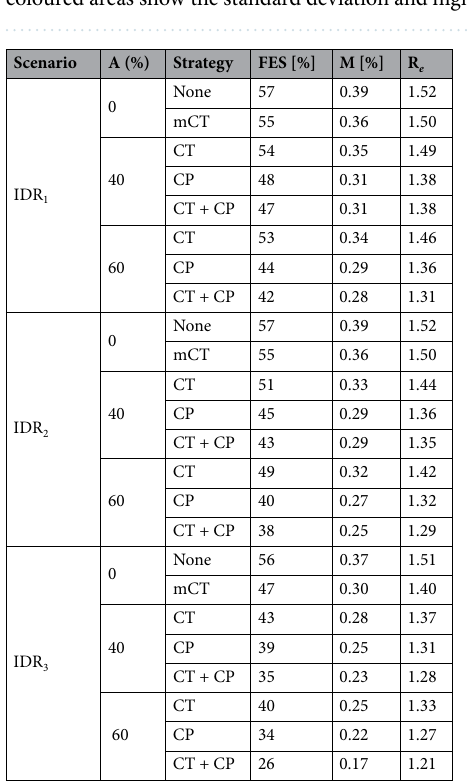
Figure 4. Final epidemic size for CT, CP, and combined CT + CP strategies for varying values of IDR at two fixed app adoption (A) rates. The cases where no strategy (none) or only manual CT (mCT) is applied are plotted as dashed lines for reference (same for both plots). Results correspond to maximum number of direct close contacts C max = 3.1 for CP and a delay D = 3 days since symptoms onset for CT. Darker and lighter coloured areas show the standard deviation and highest/lowest simulation values, respectively.